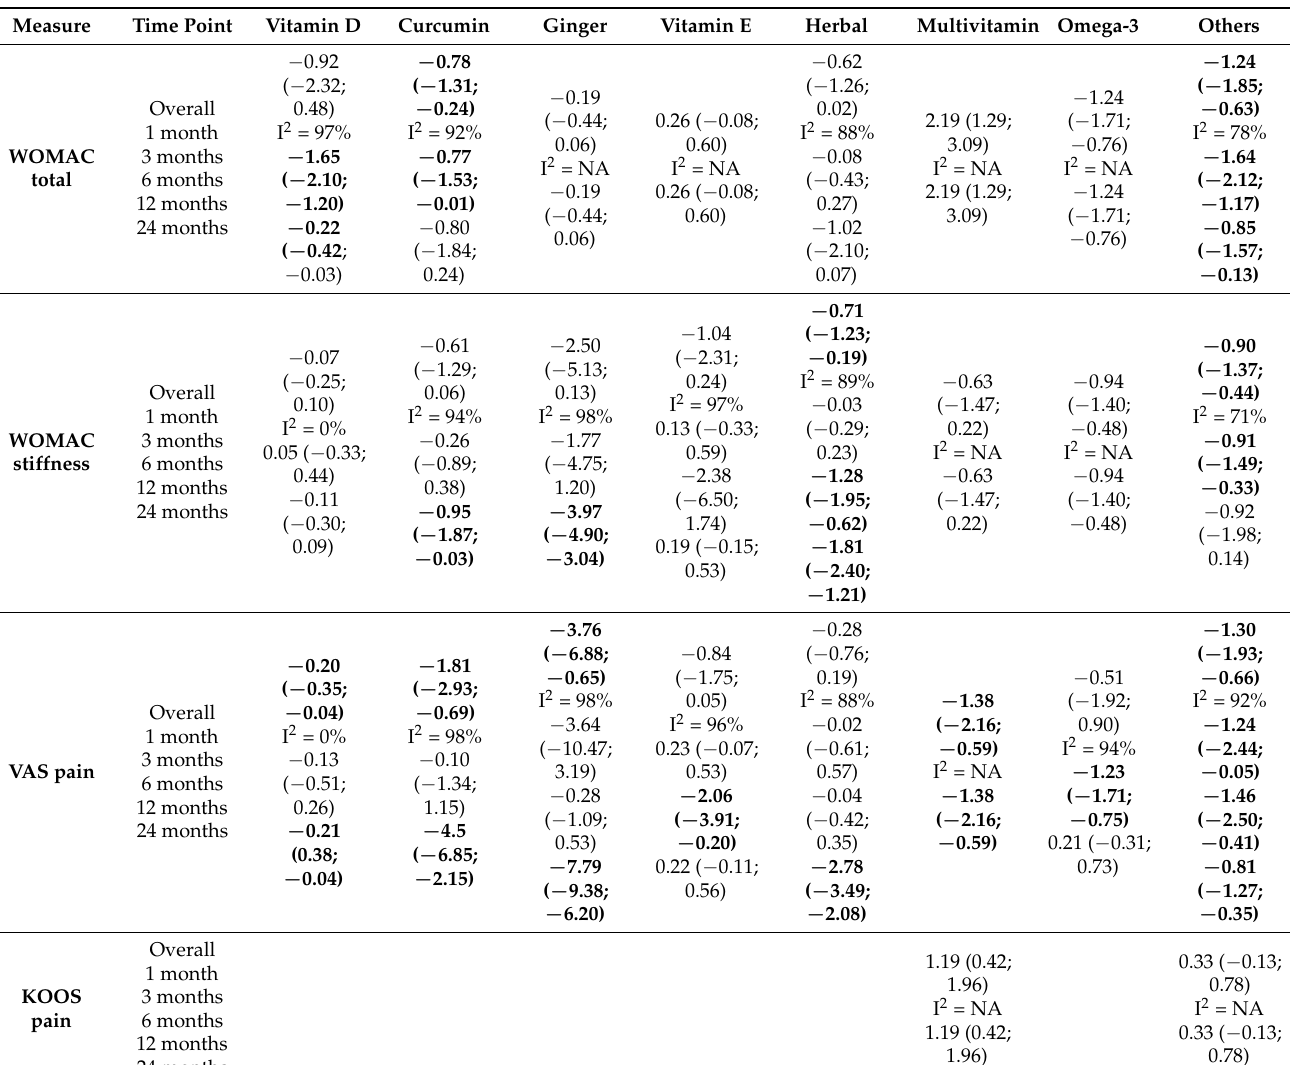
Table 2. Effects of nutritional supplements on OA parameters over